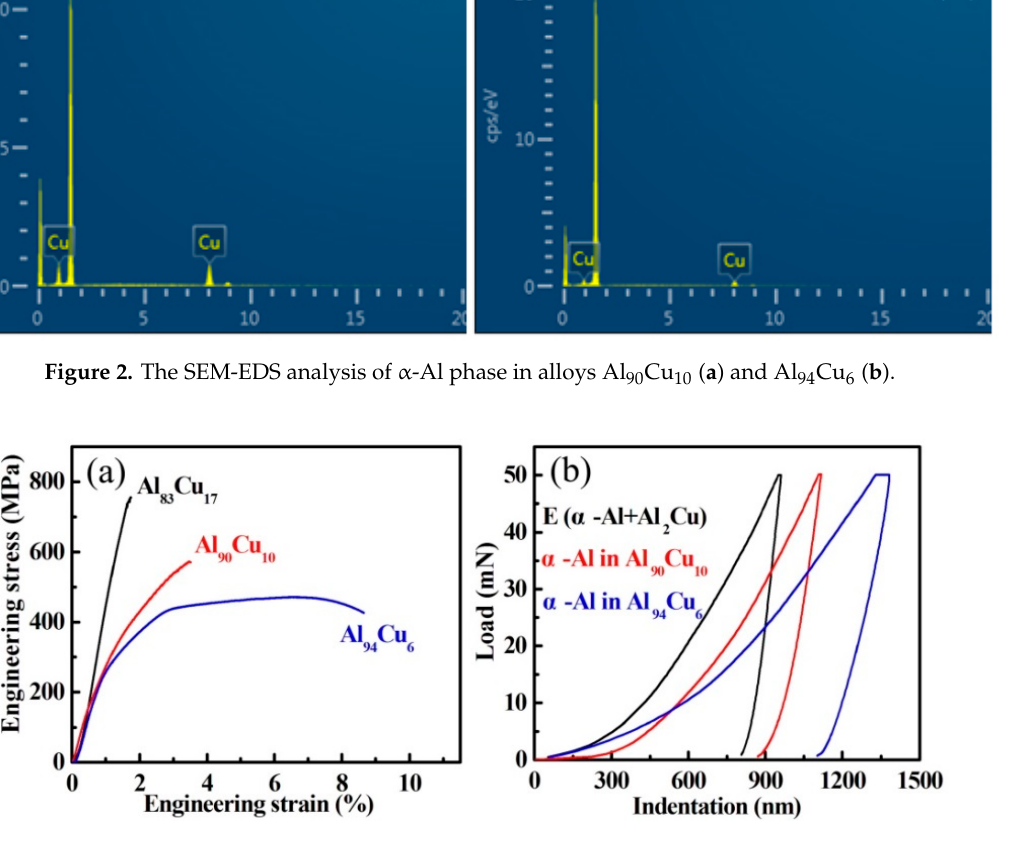
Figure 3. ( a ) Engineering tensile stress-strain curves of alloys, and ( b ) nano-indentation load-displacement curves of the ultrafine lamellar eutectic matrices and α -Al phase in alloys. Table 1. Summary of yield strength ( σ y ), tensile strength ( σ b ) and tensile plastic strain ( ε p ) of Al-based alloys.